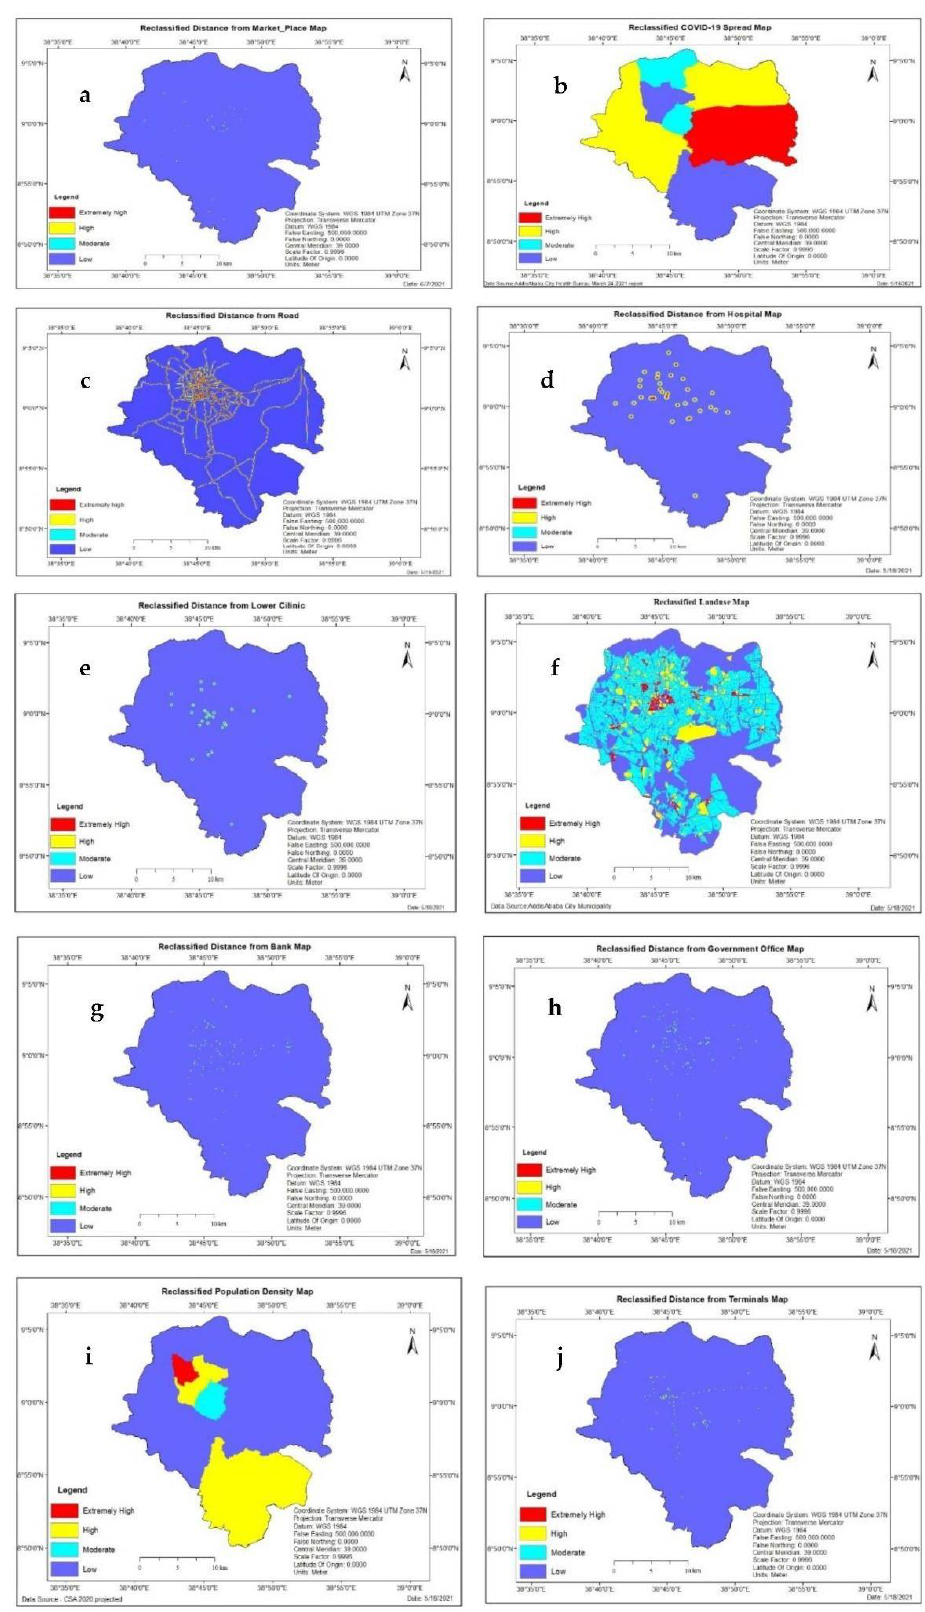
Figure 4. Standardized factors: Market place ( a ); COVID-19 case till 24 March 2021 Terminals ( b ); d-Road ( c ); Hospitals ( d ); Lower Clinics ( e ); Land use ( f ); Banks ( g ); Government office ( h ); Population density ( i ); Terminals ( j